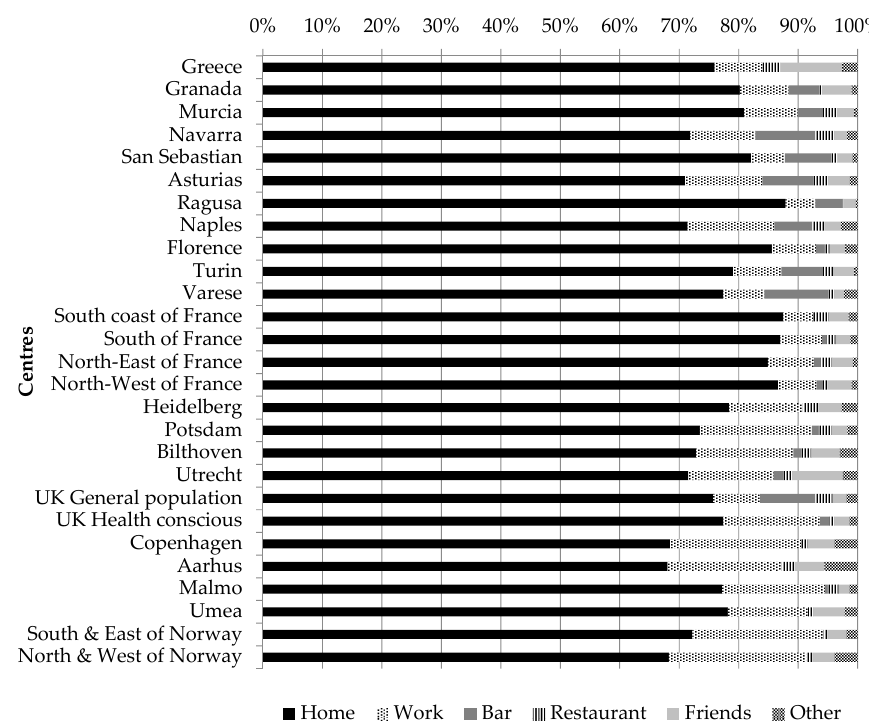
Figure 1. Proportion of coffee and tea consumption at different places of consumption, among men across EPIC centres; fully adjusted models among consumers only; “friends” refers to friends’ place.